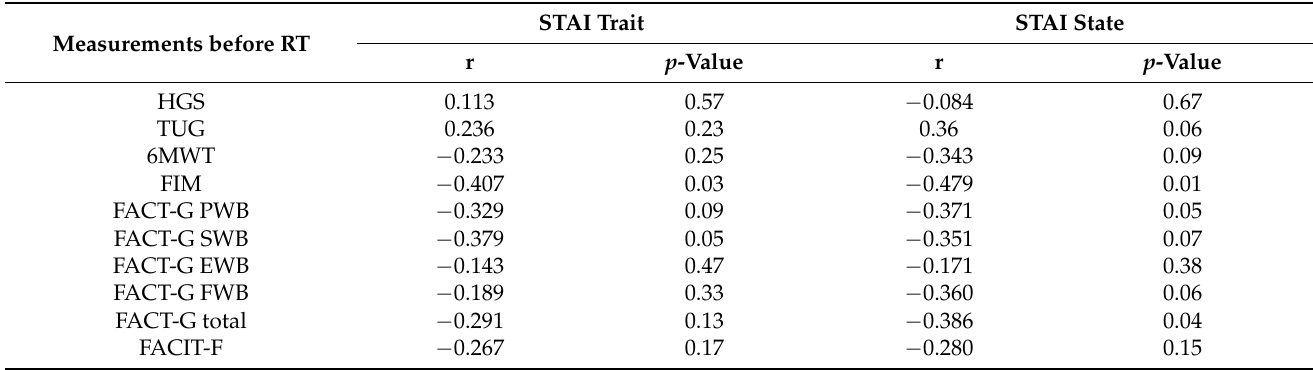
Table 4. Correlation between anxiety level and fitness tests, quality of life, and level of fatigue before RT.